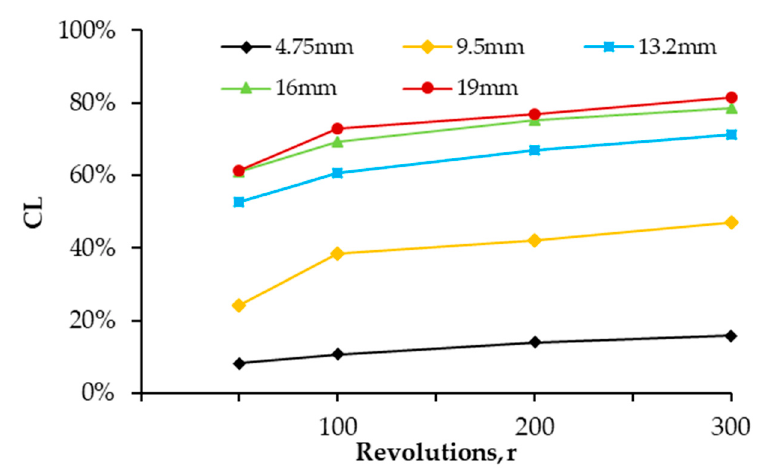
Figure 6. Effect of Revolutions on the Crushing Loss Rate of RAP 1.